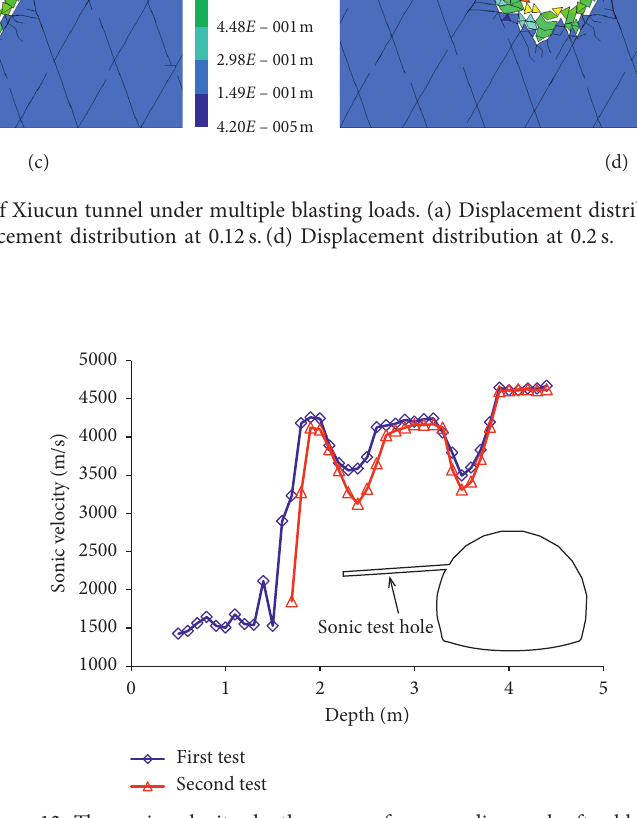
Figure 12: The sonic velocity-depth curves of surrounding rock after blasting.